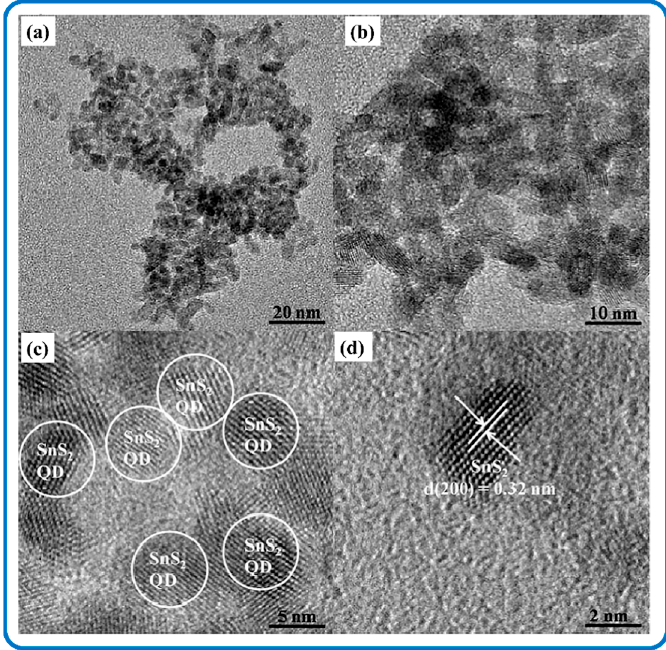
Figure 4. TEM images of SnS 2 QDs ( a , b ); HR-TEM images of SnS 2 QDs ( c , d ). Reproduced with permission from [118] . Copyright 2016, Elsevier.